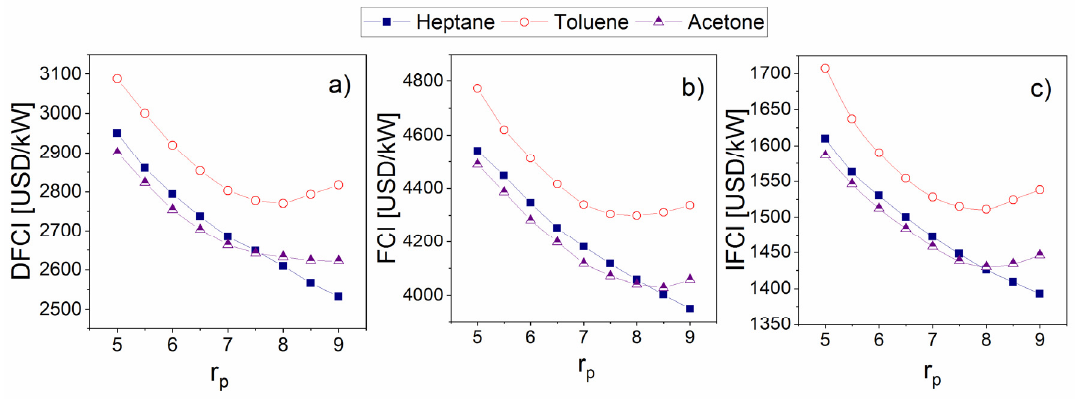
Figure 6. Effect of pressure ratio on investment costs for a RORC system varying ( a ) DFCI, ( b ) FCI, and ( c ) IFCI.